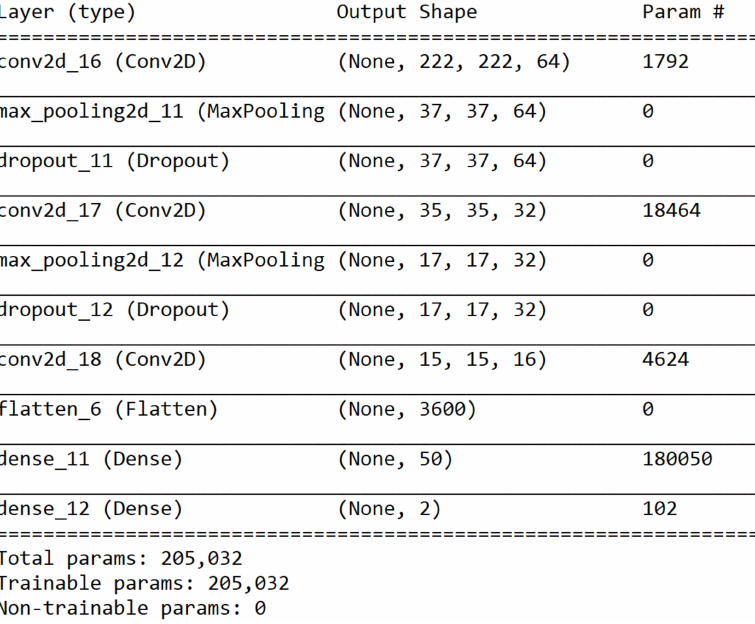
Figure 17. A summary of the CNN model in the second stage of the proposed